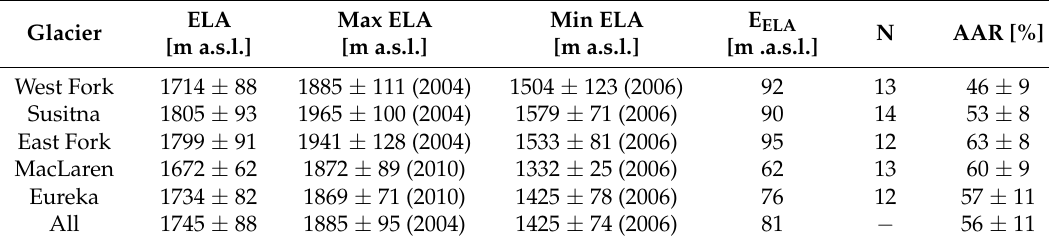
Table 4. Statistics of ELA and AAR analysis for the five large glaciers over the period 1999–2015. ELA and AAR values refer to the mean over the study period and N denotes the number of years with valid data. Values also include the standard deviation of the annual values as a measure of interannual variability. Maximum and mean ELA include the uncertainty based on Equation 2 and the corresponding year in bracket. E ELA refers to the arithmetic mean of the annual ELA uncertainties. “All” refers to the arithmetic mean of the values (and uncertainties) of the five large glaciers. Glacier